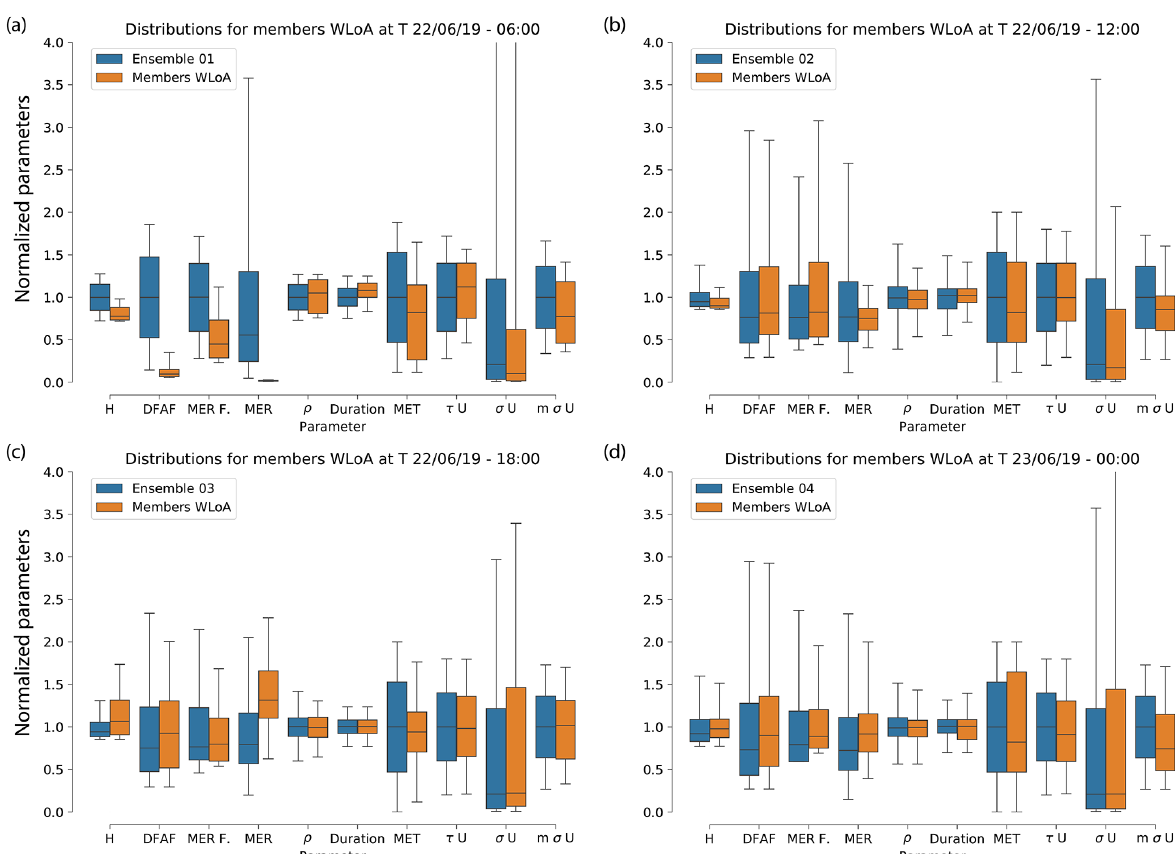
Figure 4. Evolution of parameter distributions for members within limits of acceptability (WLoA) for (a) Ensemble 01, (b) Ensemble 02, (c) Ensemble 03, and (d) Ensemble 04. ρ , τU , σU , and mσU represent density, horizontal Lagrangian timescale for free tropospheric turbulence, standard deviation of horizontal velocity for free tropospheric turbulence, and standard deviation ( σ ) of horizontal velocity for unresolved mesoscale motions. In (a) , (b) , (c) , and (d) , the mass eruption rate (MER) is plotted to show its variation, although it is not explicitly perturbed in any of the ensembles. Each parameter in the box plots is normalised by dividing each individual value from the ensemble members by the mean of that entire parameter range from the selected ensemble. The evolution of parameters distributions for ENS05–ENS11 are shown in Appendix A (Fig. A1).